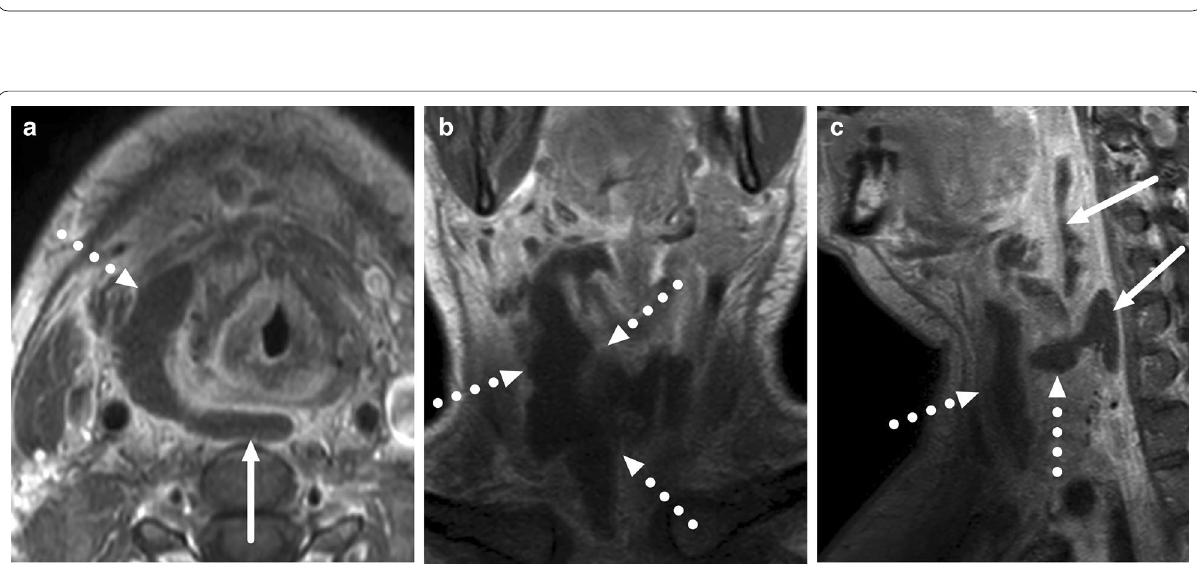
Fig. 7 Multi-space abscess on axial fat-suppressed T2-weighted ( a ) and post-contrast T1-weighted ( b ) images. An odontogenic abscess affects the parapharyngeal (arrows), parotid (dashed arrows), and masticator (dotted arrows) spaces